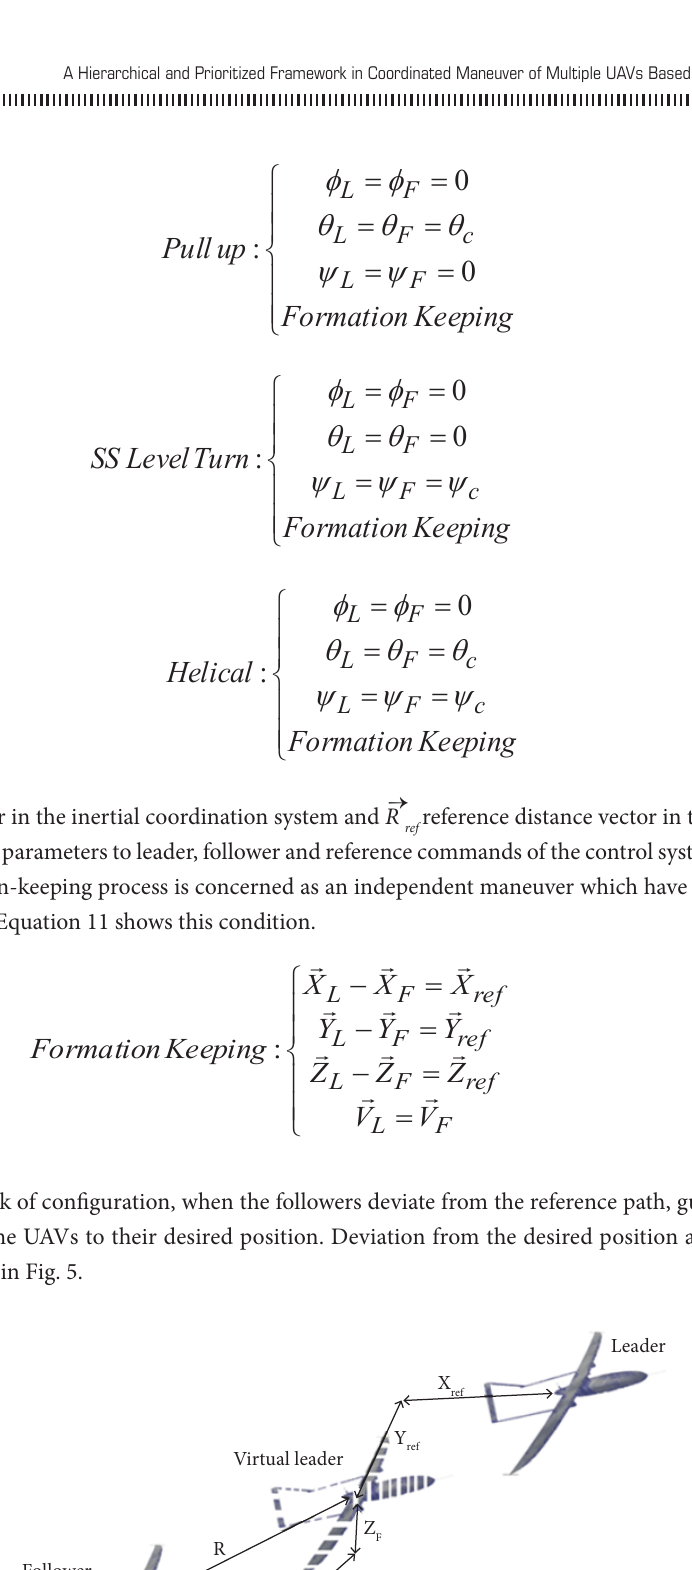
Figure 5. Distance parameter and virtual point position. The coordination of virtual leader as a guidance reference point ( X ref , Y ref , Z ref = 0) is expressed in the body coordinate system of the leader and the coordination of the follower is